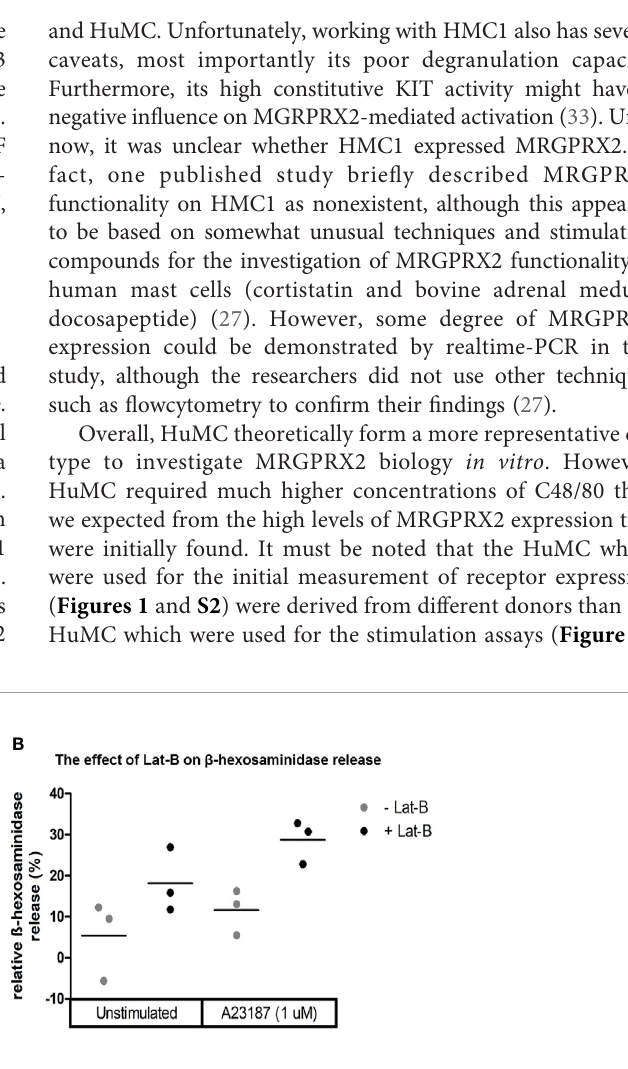
FIGURE 3 | Calcium ionophore A23187 induced degranulation of HMC1 with or without Lat-B. HMC1s pre-incubated with 2 µg/ml Lat-B for 24 hours showed an overall higher fold induction of CD63 expression upon stimulation with 1 m M A23187, as compared to HMC1 cells without pre-incubation (A) . The same effect was seen on b -hexosaminidase release (B) . No substantial differences were seen regarding the length of stimulation time.